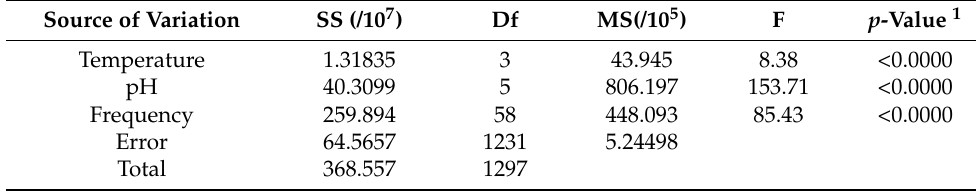
Table 3. Two-Way ANOVA results for Vpp with all gathered data.